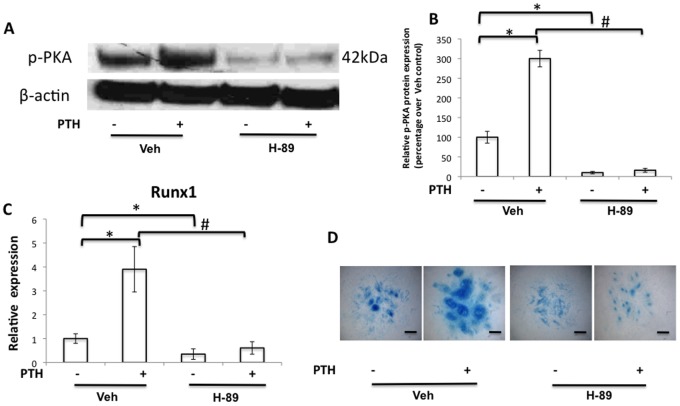
PKA inhibitor blocked the synthesis of Runx1 and chondrogenesis induced by PTH.Limb bud cells were treated for 4 days with 10 µM PKA inhibitor H-89 and/or PTH 1–34 before protein and RNA were extracted and Alcian blue staining at day 5 of culture. (A) Phospho-PKA (p-PKA) protein levels were visibly reduced by H-89. (B) Quantification of Phospho-PKA protein expression in Western blots using ImageJ software. Data are means ± SD of three independent experiments. (C) PTH-induced Runx1 expression was drastically reduced by co-treatment with H-89. Data are means ± SD of three independent experiments performed in duplicate and the control Runx1 expression level was set at 1. (D) A reduction in chondrocyte nodule formation was seen in H-89-treated cells with/without PTH. Scale bars, 100 µm. (*p<0.05 compared with vehicle control; #p<0.05 compared with PTH without H-89).